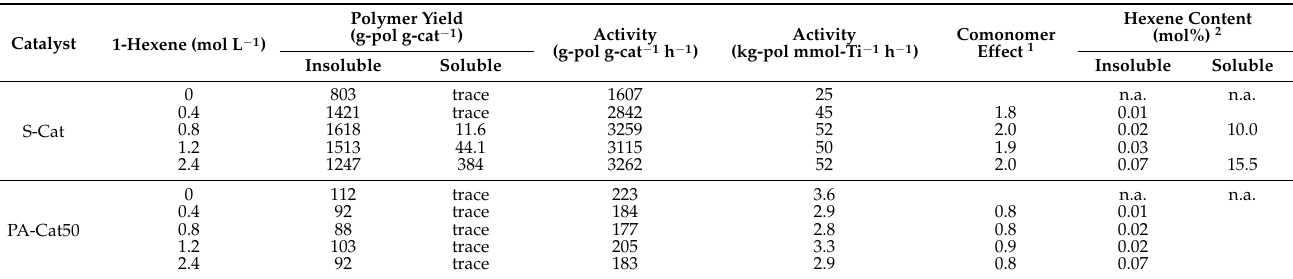
Table 3. 1-Hexene copolymerization with ethylene.